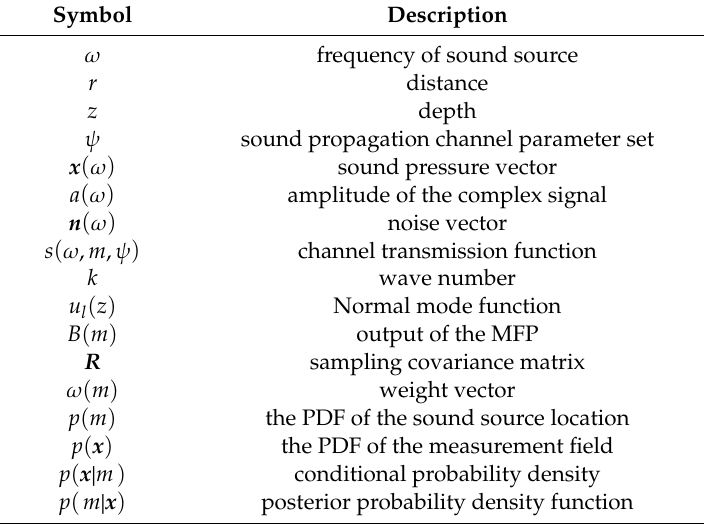
Table 1. Notation